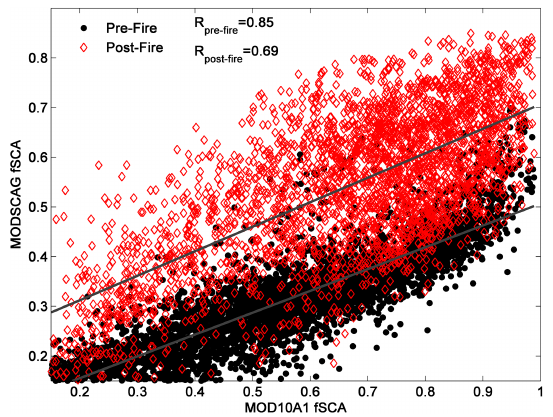
Figure 3. Least-squared linear regression analysis of MOD10A1 and non-adjusted MODSCAG over the Moonlight Fire domain pre- (black circles) and post-fire (red